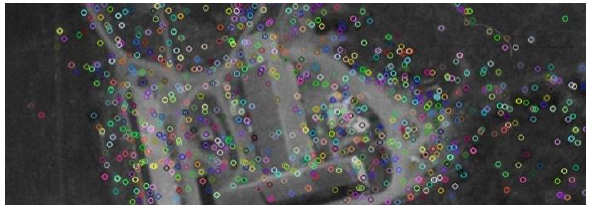
Figure 6. An example of detected key features